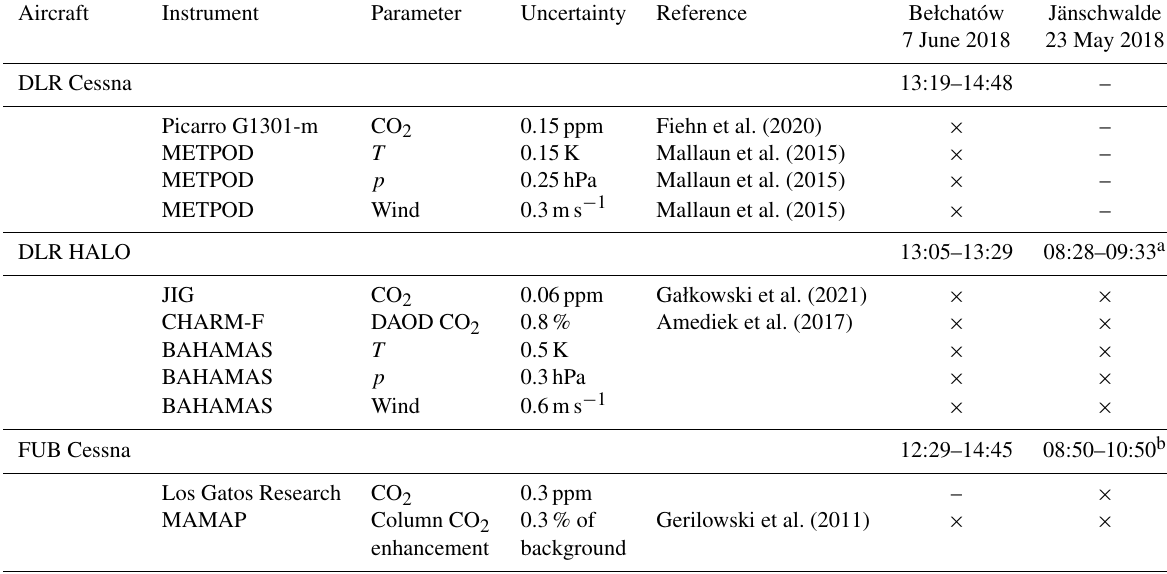
Table 1. An overview of the measurements used for model evaluation. The time range indicated for each aircraft is not the time between takeoff and landing but corresponds to the range between start of the first plume transect and the end of the last transect in Universal Coordinated Time (UTC). The availability of an instrument is indicated by a × symbol. Note that ppm is parts per million.